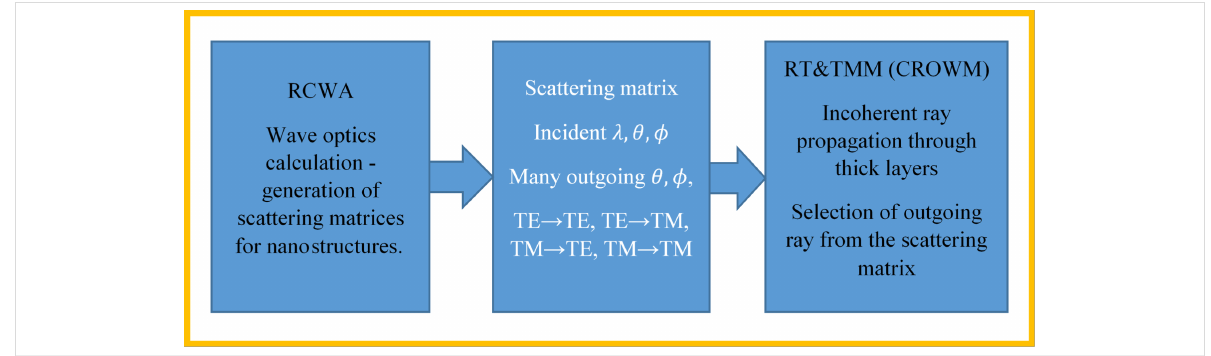
Figure 2: Principle of the coupled modeling approach (CMA). RCWA is applied to the parts of the structure where nanotextures are present to produce scattering matrices. These matrices are an input for the RT and TMM part of the simulator. By applying iterative coupling, the optical situa- tion in the region of nanostructures, microstructures, thin and thick layers can be simulated in an effective and accurate